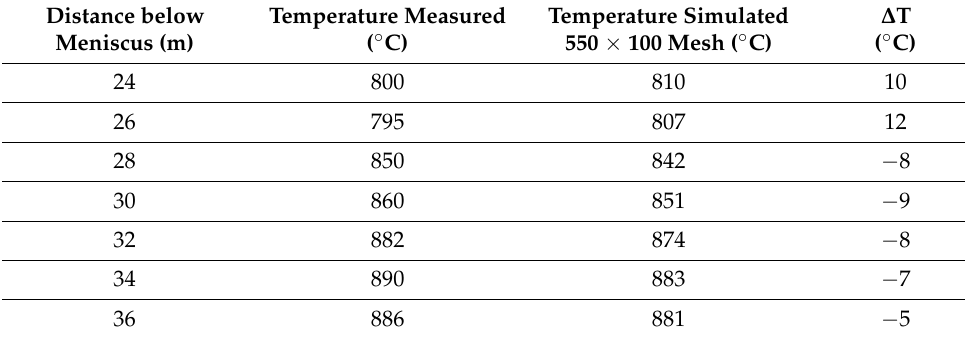
Table 11. Calculated errors for the simulated slabs, case